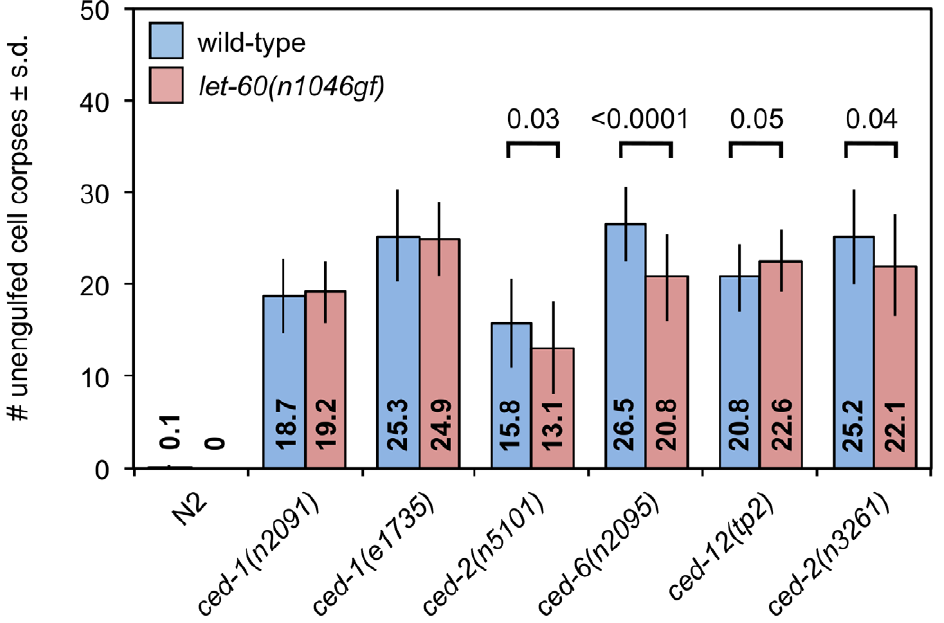
Figure 7. A let-60 Ras gain-of-function mutation does not affect apoptotic cell engulfment. The heads of engulfment gene mutant L1 animals with or without the let-60(n1046gf) mutation were scored for engulfment defects using DIC microscopy. The mean 6 standard deviation (s.d.) is indicated within each bar. Error bars are sd. p values derived using Student’s t test are shown. At least 15 animals were tested for each genotype.